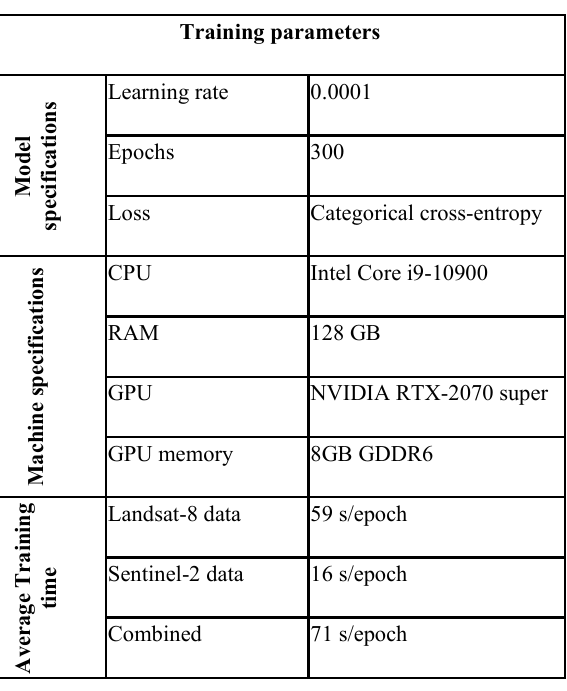
Table 2: Model parameters and machine specifications.